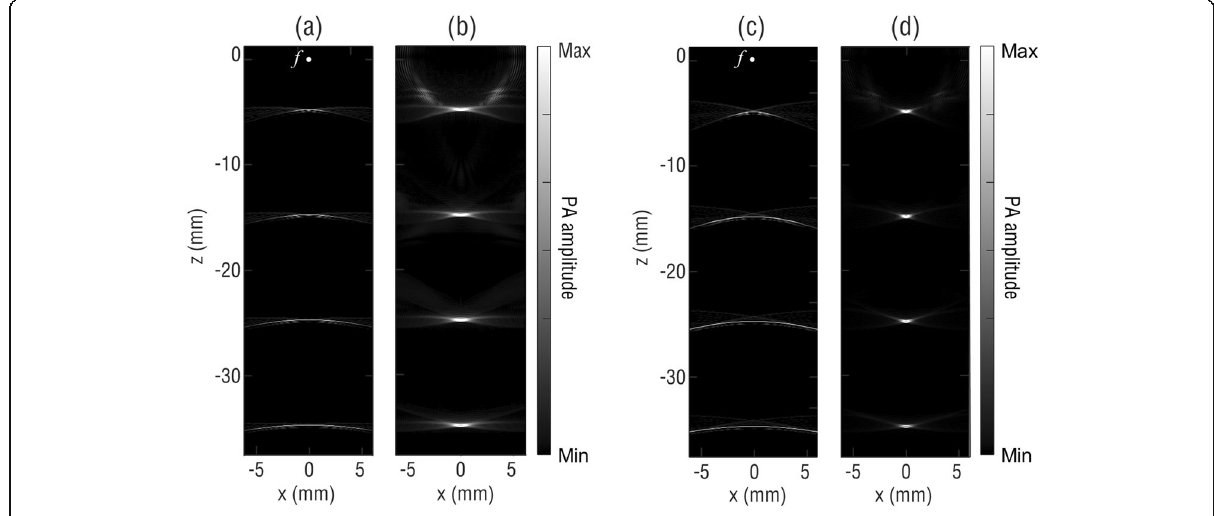
Fig. 4 Simulated B-scan and SAFT images detected using a focused fiber with an NA of 0.18 ( a, b ) and 0.36 ( c, d )